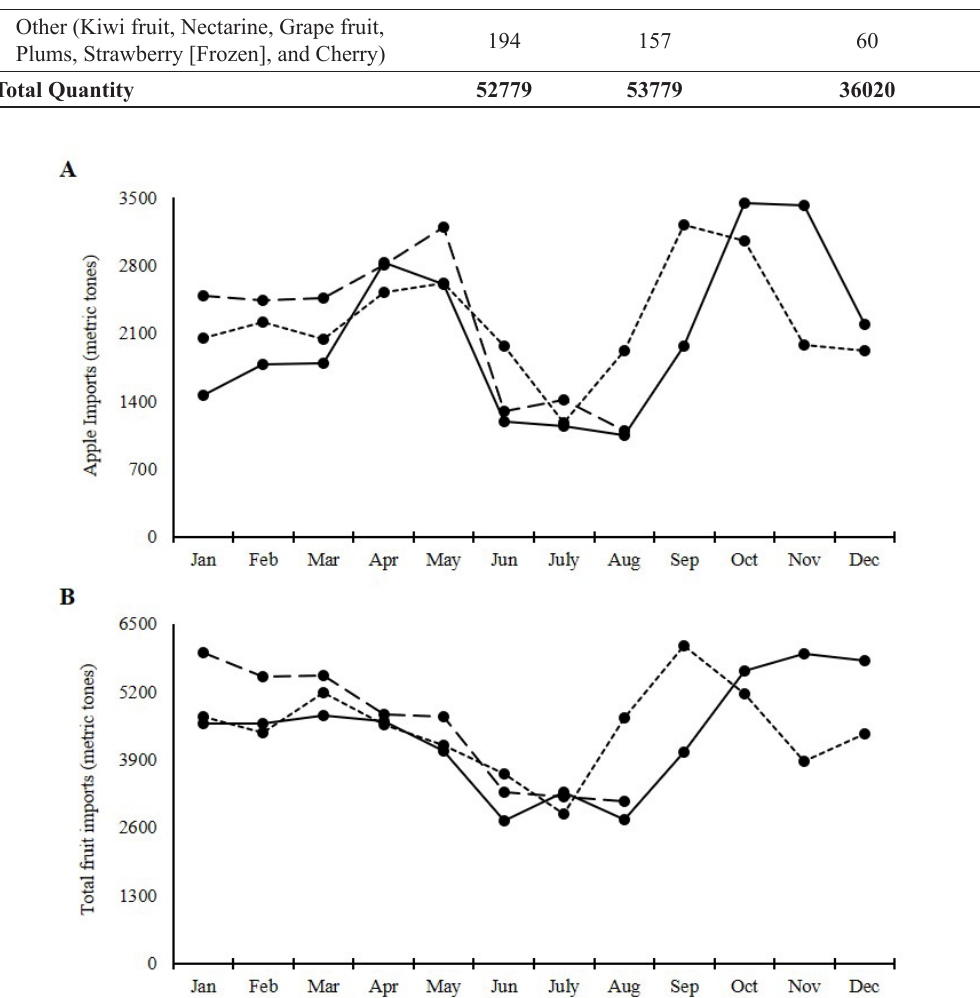
Figure 2: The quantitative variation of the fruit importations to Sri Lanka. A: Apple imports; B: Total imports. Solid line: 2016; Small dashed line: 2017; Large dashed line: 2018. For 2018, the data are only available till